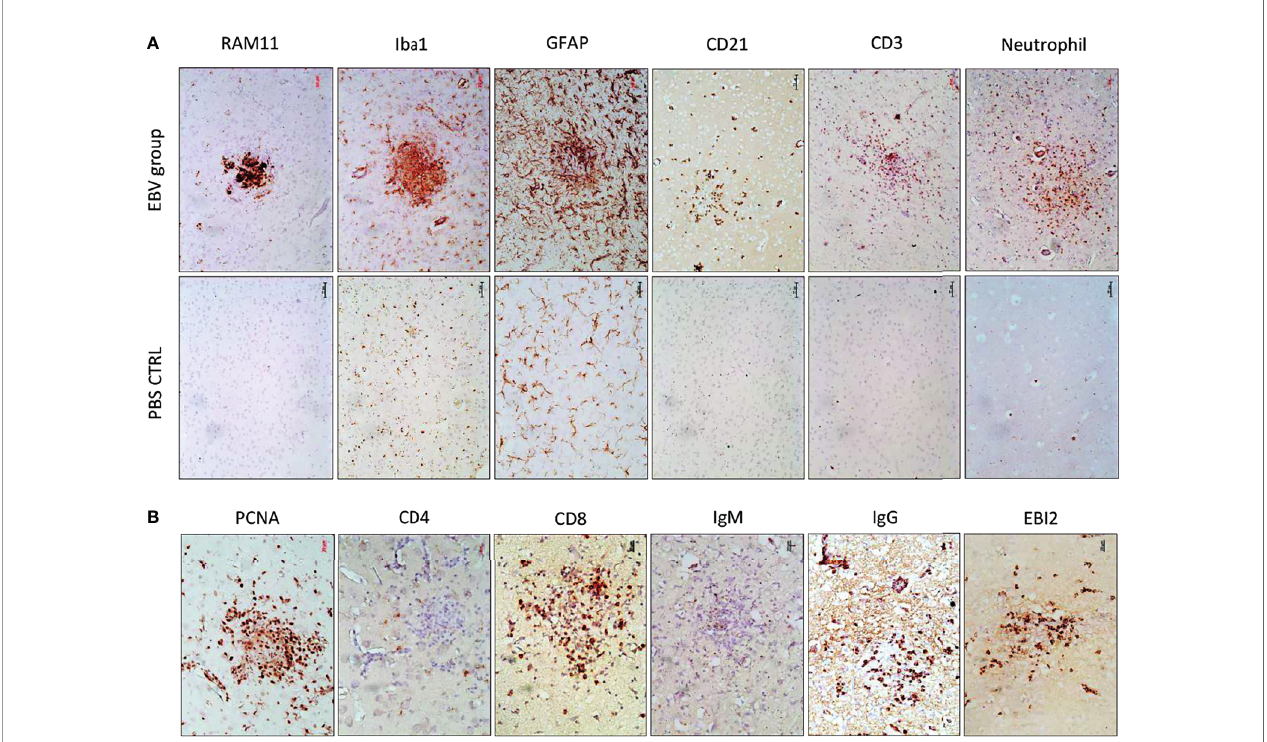
FIGURE 3 | The cellular makeup of cerebral aggregates in EBV infected rabbits. (A) Brain sections from EBV infected rabbits with cerebral aggregates and PBS controls were stained with rabbit-speci fi c maker for macrophages (RAM11), microglia (Iba1), astrocytes (GFAP), B cells (CD21), T cells (CD3), and neutrophils. Scale bar=50 m m. (B) Additional phenotypic characterization of lymphoid in fi ltrates by staining for the proliferation marker PCNA, T and B cell markers CD8, IgG, IgM, and Epstein-Barr virus-induced gene 2 (EBI2). Scale bar=20 m